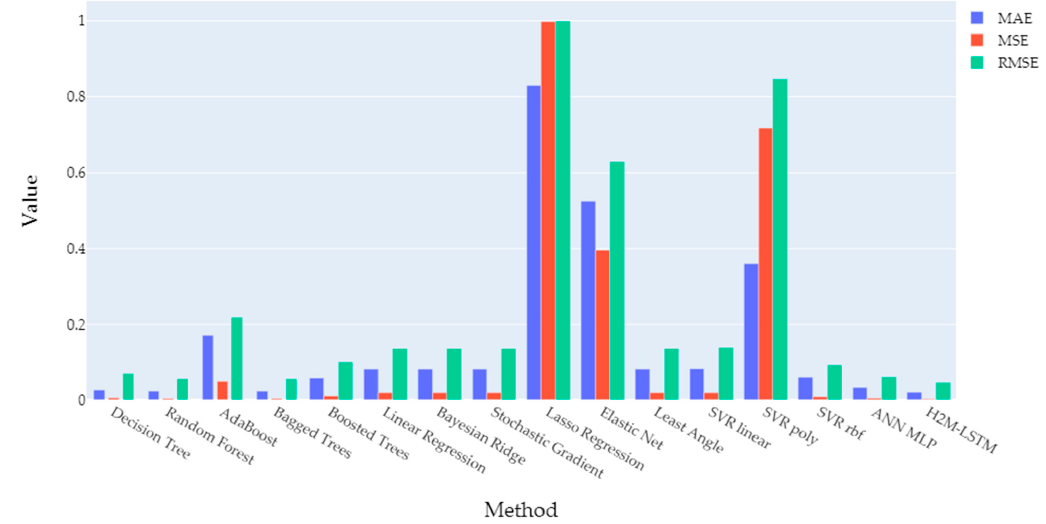
Figure 9. Barplot comparison of the performance metrics for the heat exchanger.